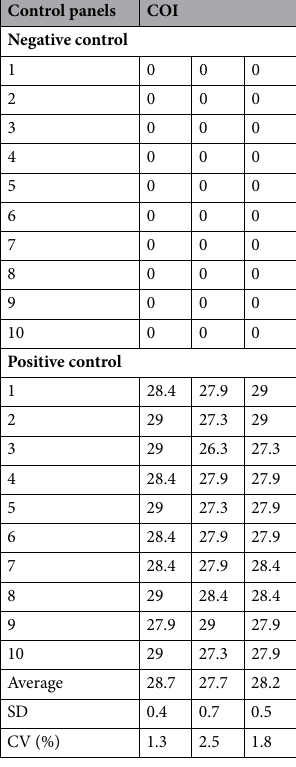
Table 1. Within-run reproducibility. The COI values of samples without or with SARS-CoV-2 antigens were measured a total of 30 times (three sets of 10 consecutive measurements). COI cutoff index, SD standard deviation, CV coefficient of variation.